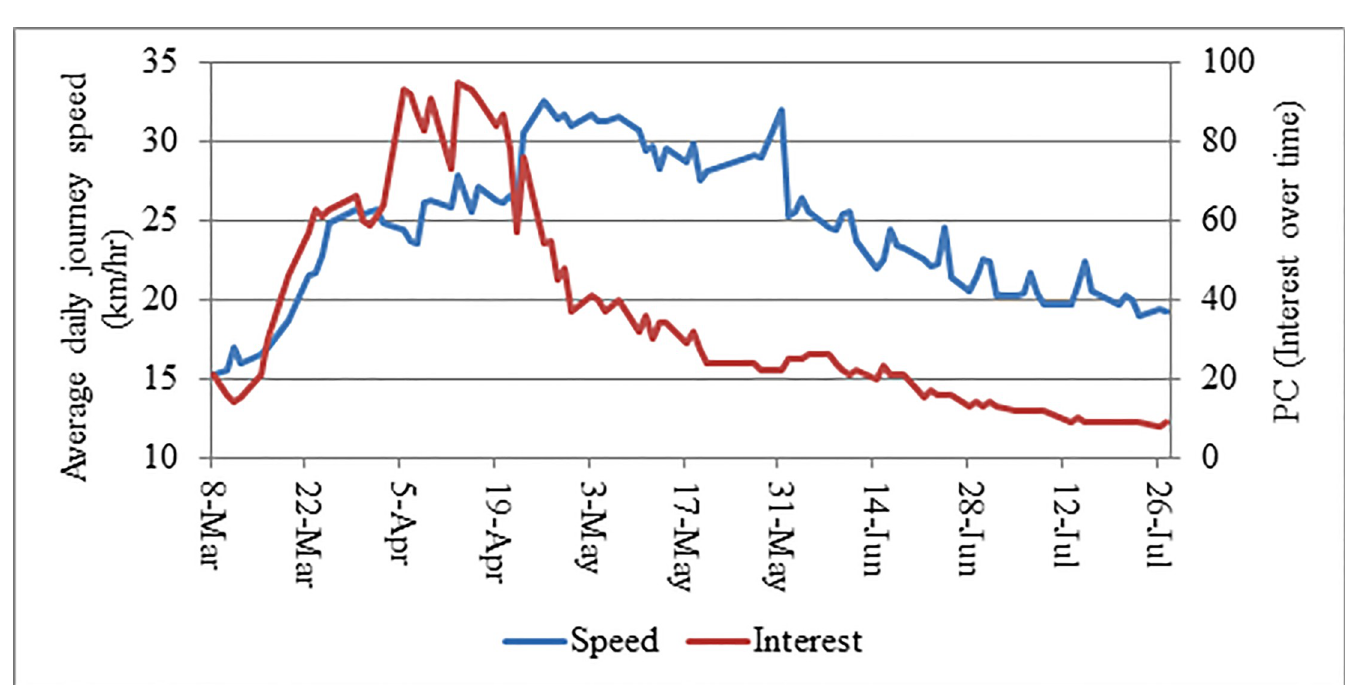
Fig 4. Time series of average daily journey speed ( ADJS) and public concern and interest about COVID-19 ( PC ).